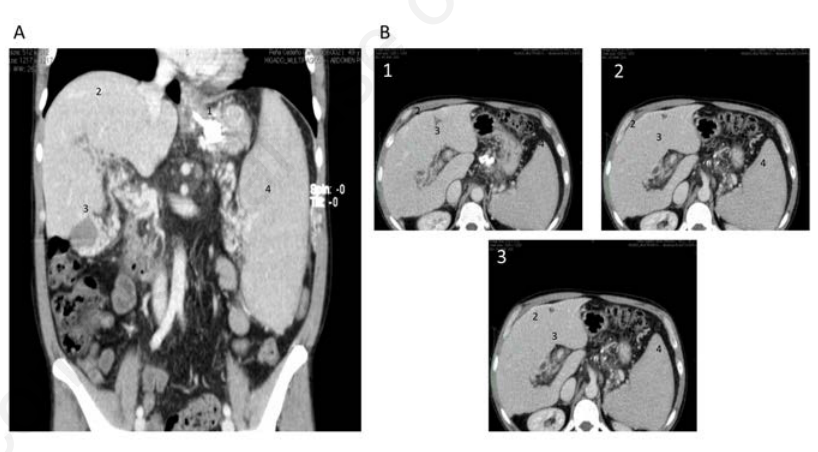
Figure 1. Liver computed tomography at the time of surgery. A) Longitudinal section; B) transversal sections: before (1), at (2) and after portal bifurcation (3).